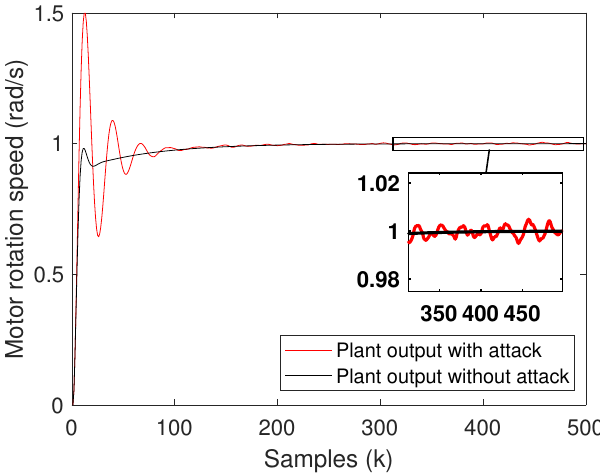
Figure 10. Motor speed with and without attack.